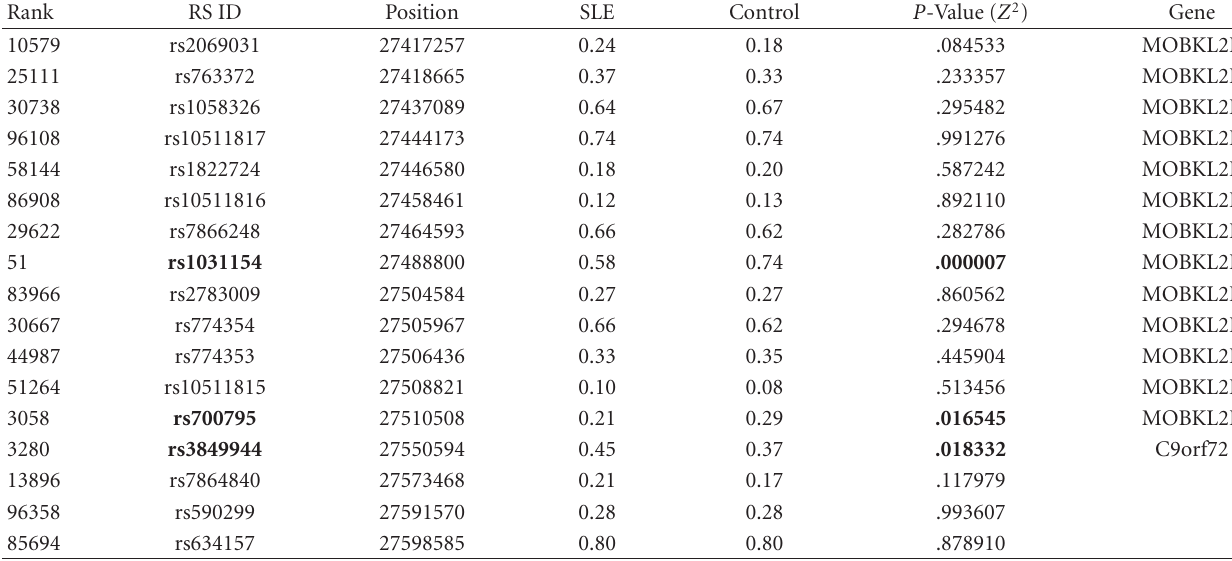
Table 1: Initial results for the IFNK region in the pooled genome-wide association study In African-American